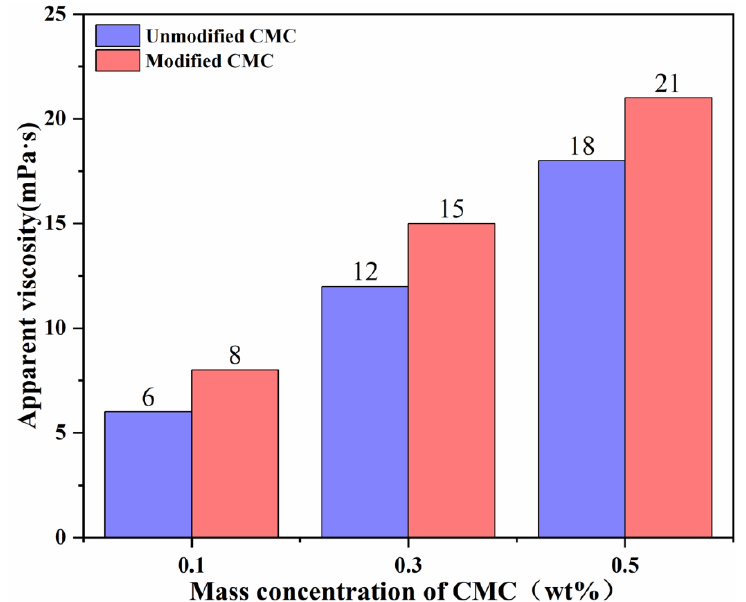
Figure 15. Apparent viscosity of modified CMC and unmodified CMC in 10,000 ppm Ca 2+ salinity water.